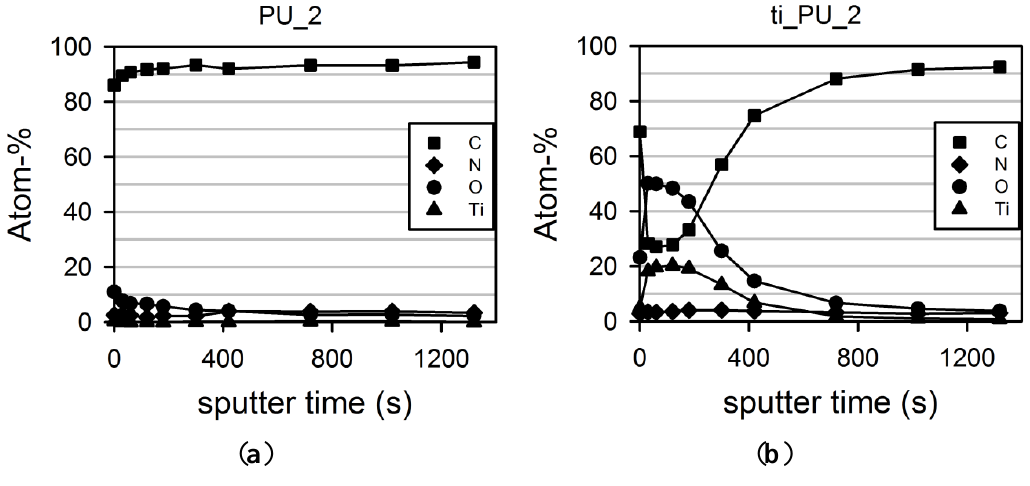
Figure 1. Representative XPS of ( a ) pure and ( b ) titaniferous upgraded PU_2. Surface characteristics show a homogenous composition of carbon (C), oxygen (O), titanium (Ti) and nitrogen (N) on titaniferous upgraded ti_PU_2 and pure PU_2 (control). The spectrum of the upgraded surface which can be regarded lies in the measuring range between 30 and 1000 sputtering